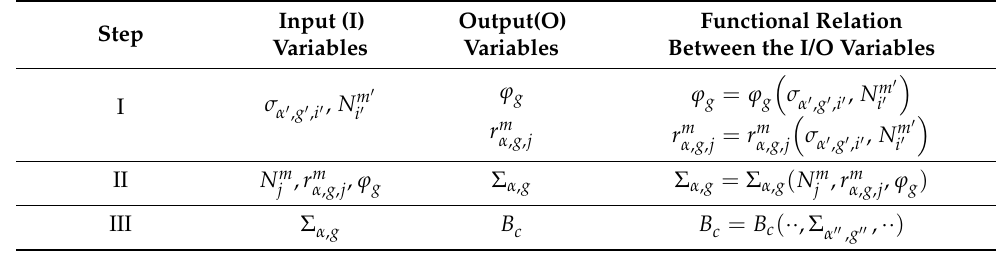
Table 1. Functional relation between input and output variables for each step in critical buckling generation using the B 1 theory-augmented MC